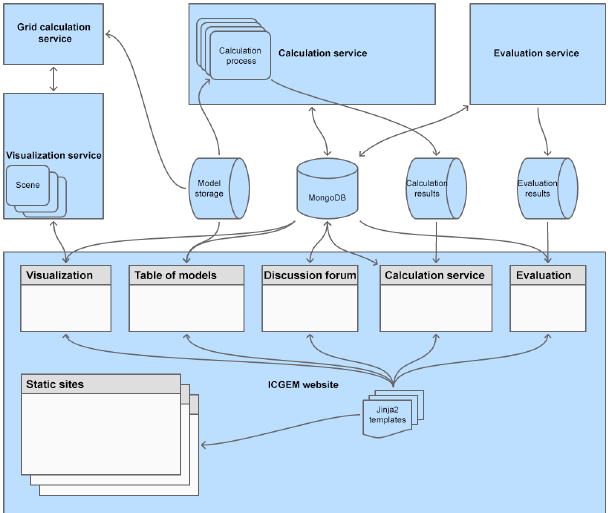
Figure 20. Illustration of the scheme of the ICGEM website in terms of its web programming. Arrows indicate the direction of data flows. Cylinders are the default symbol for databases and sideway cylinders are used for file-based data storage. Model storage is file based, while the calculation results are the calculated grid files and the images converted from them. Evaluation results are only the generated images on the spectral domain page; the values in the GNSS/levelling page derive from the MongoDB. At the bottom of the scheme, every grey-white rectangle represents a subpage on the website. Similar pages, like the different visualization pages or the tables of models, are presented together, and we included only the static pages that are more interesting from a technical